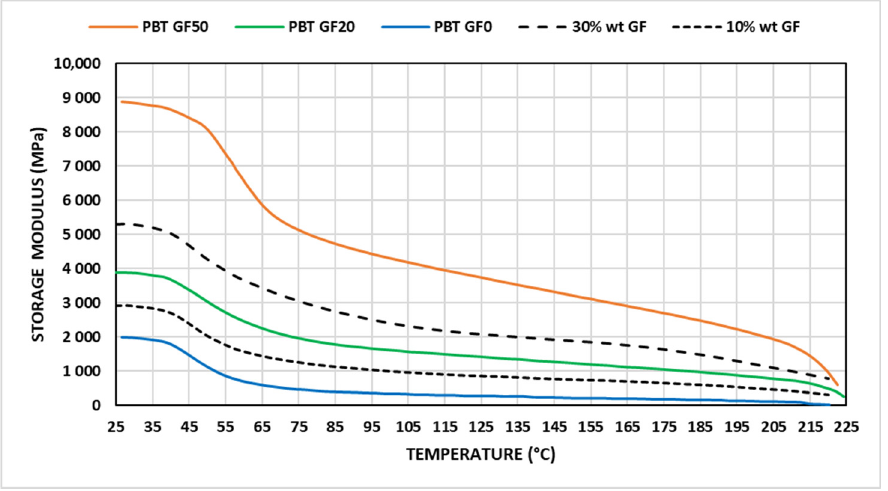
Figure 3. Variation in the storage modulus with temperature (f = 1 Hz).